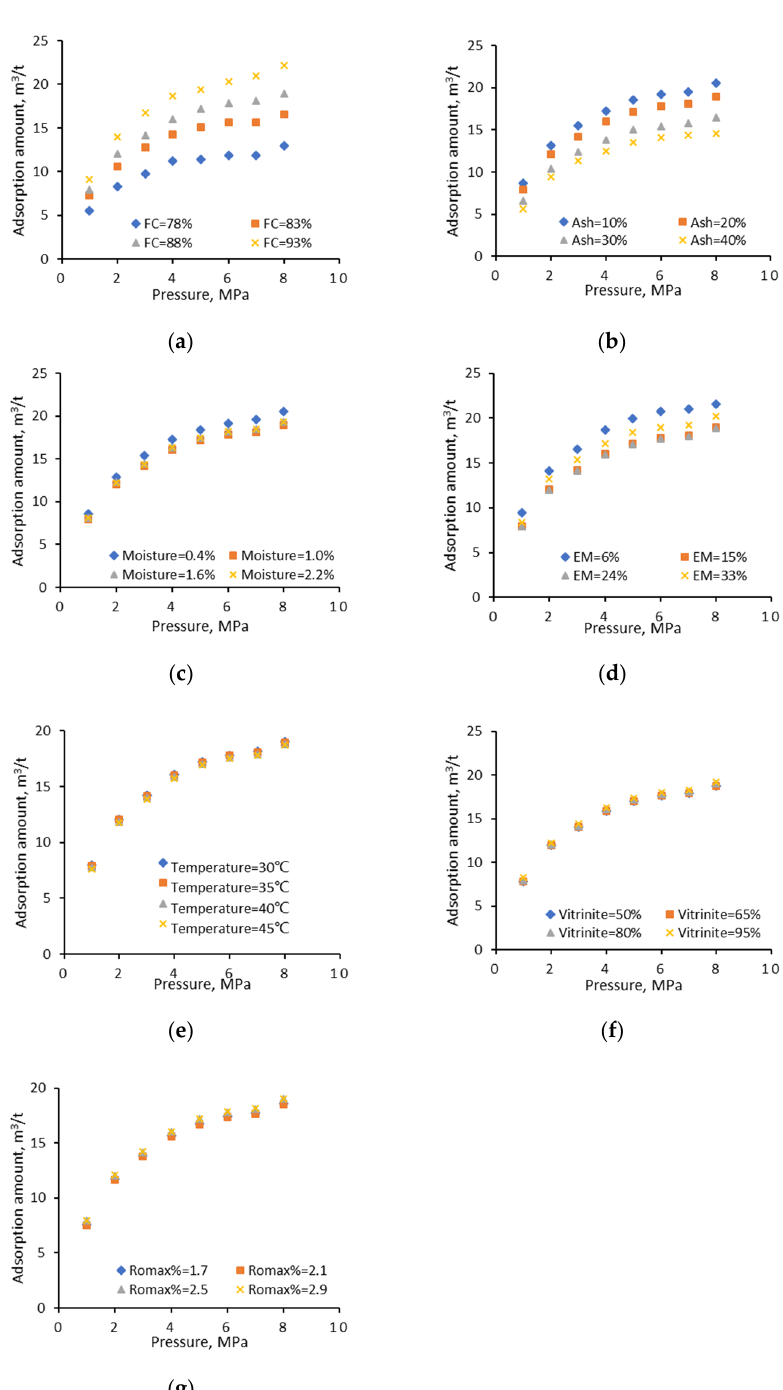
Figure 12. Calculated adsorption isotherms using the constructed GBDT model with reference to varying ( a ) fixed carbon (d.a.f), ( b ) ash (a.d.), ( c ) inherent moisture (a.r.), ( d ) equilibrium moisture, ( e ) temperature, ( f ) vitrinite (m.m.f), and ( g ) vitrinite reflectance.